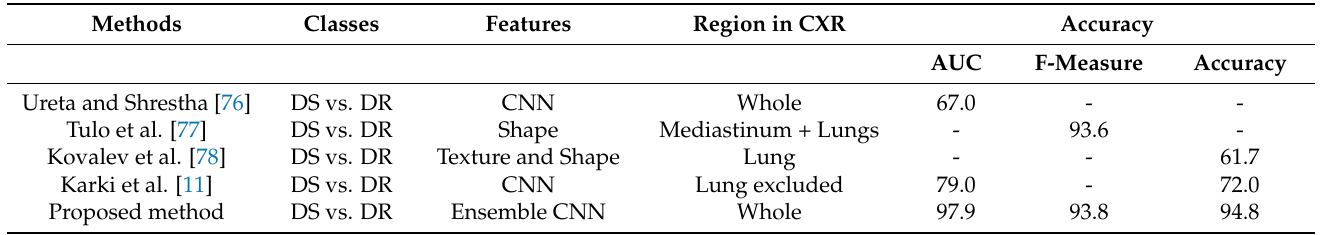
Table 8. The accuracy of the proposed methods with the existing heuristics to classify DR-TB and DS-TB.